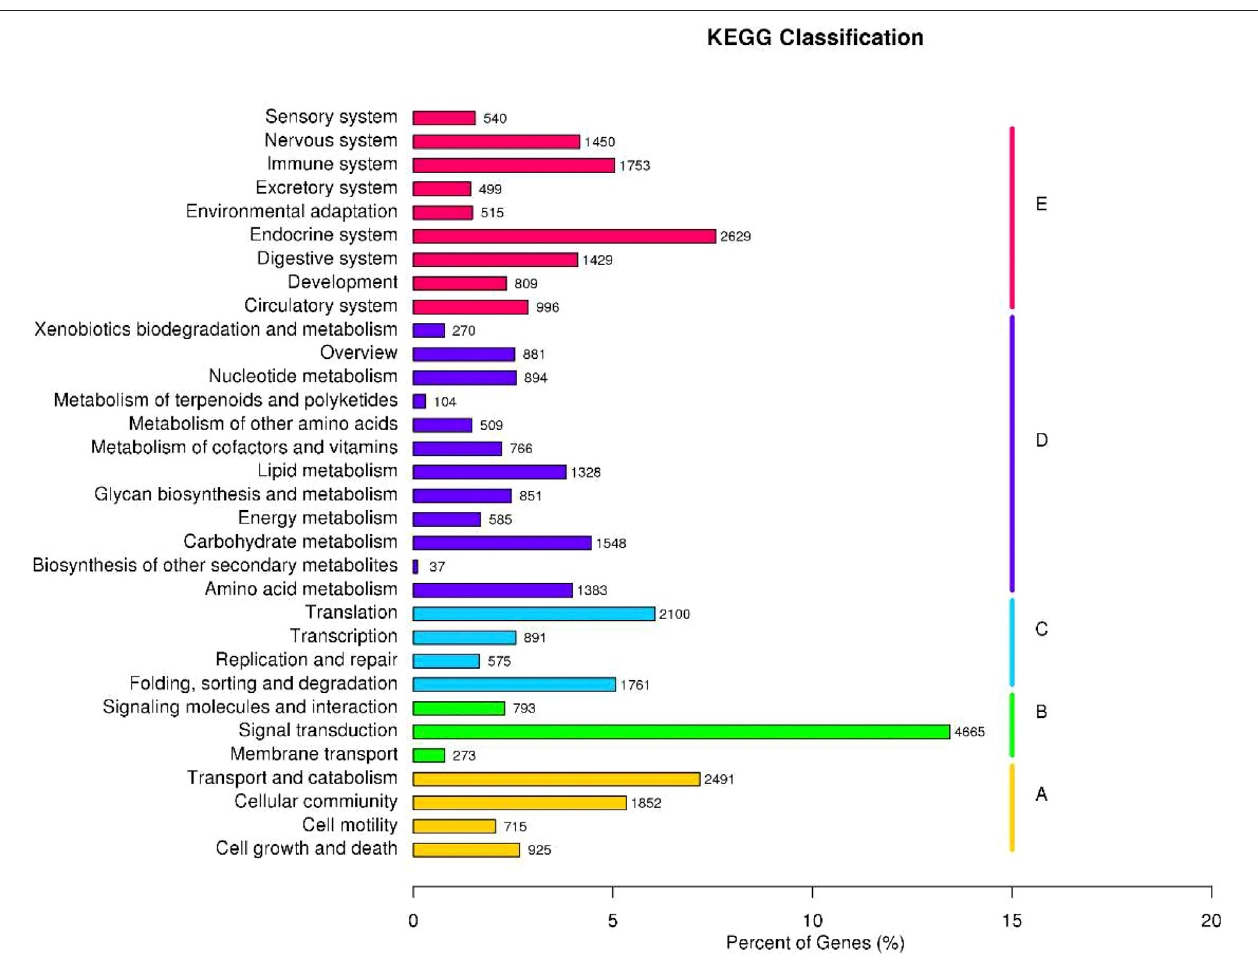
FIGURE 3 | Function annotation and classi fi cation of P. trituberculatus unigenes in the KEGG category.